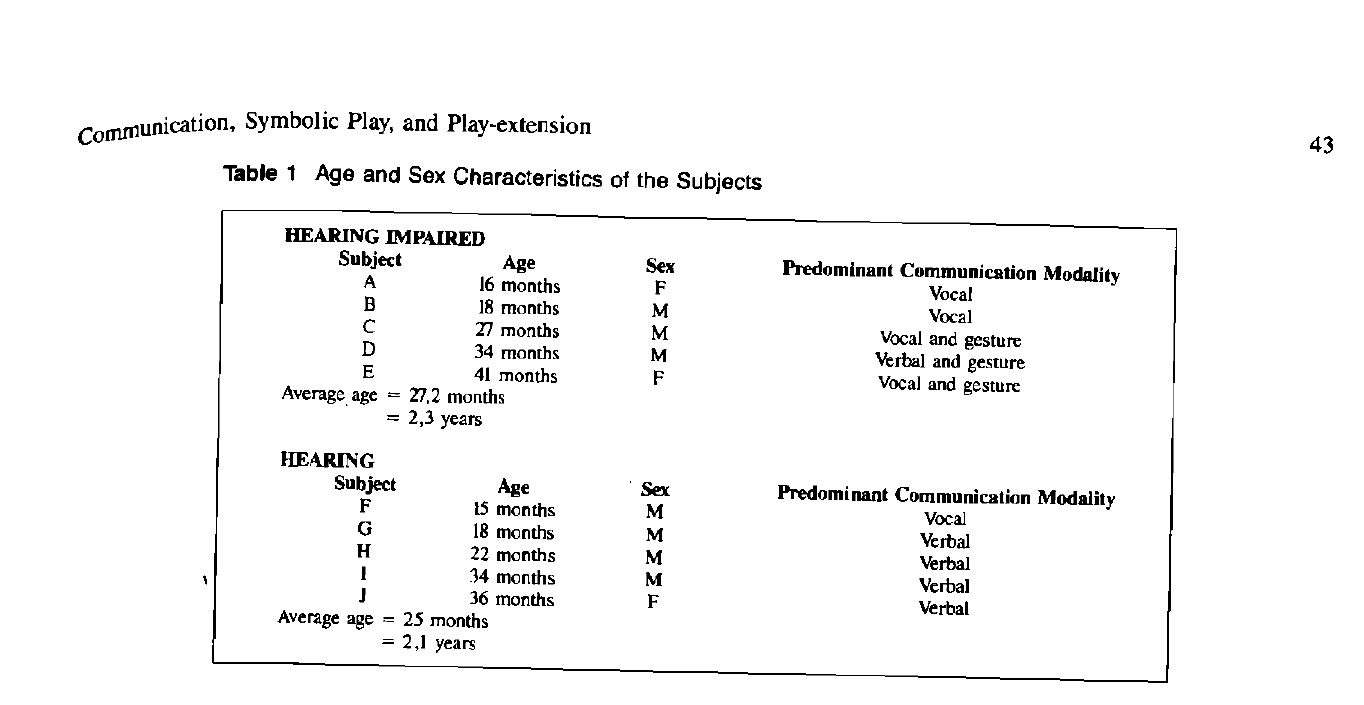
Table 1 Age and Sex Characteristics of the